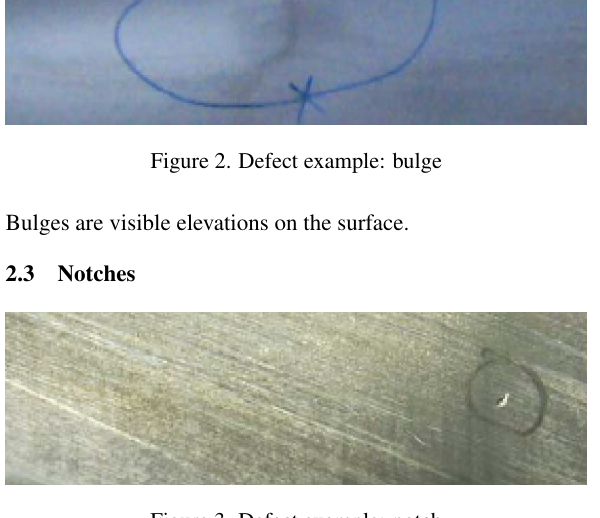
Figure 3. Defect example: notch Notches are tiny craters in the surface. 2.4 Waviness Figure 4. Defect example: waviness Waviness denotes a series of dents and bulges in succession.